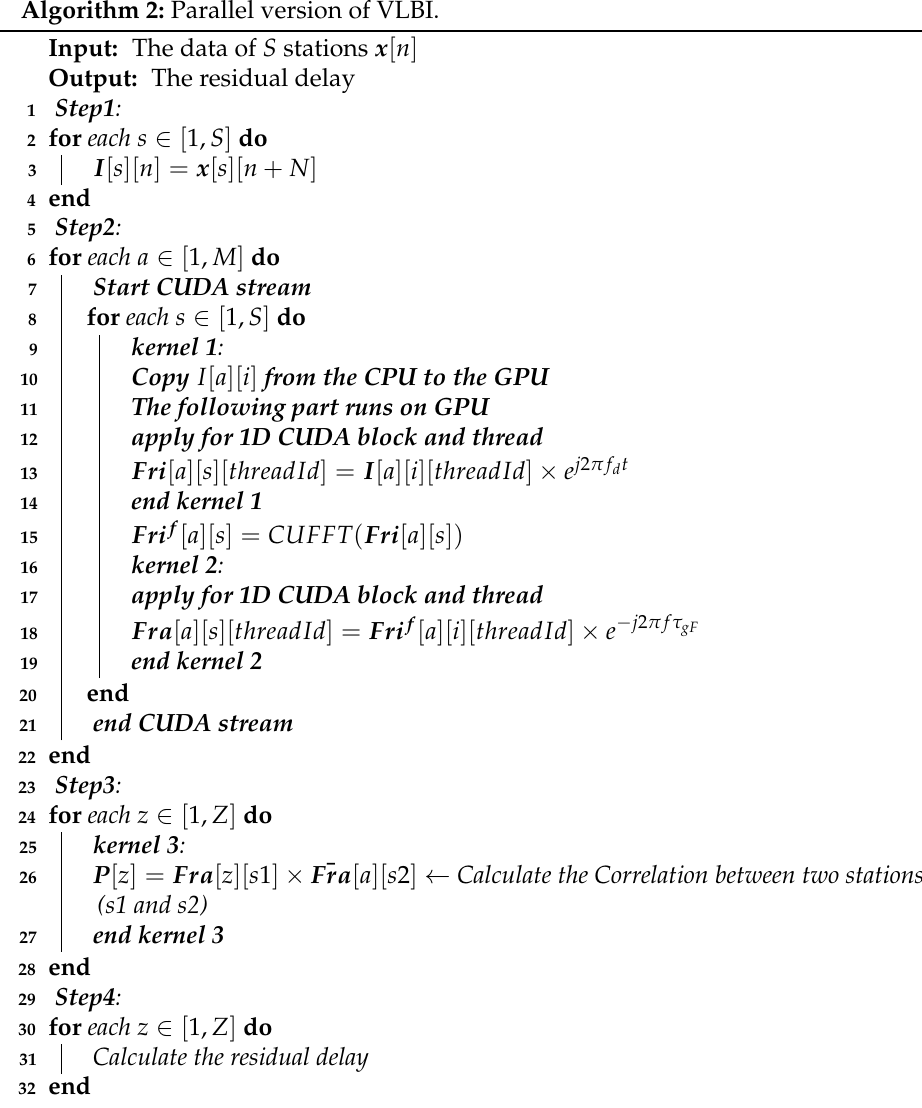
Algorithm 2: Parallel version of